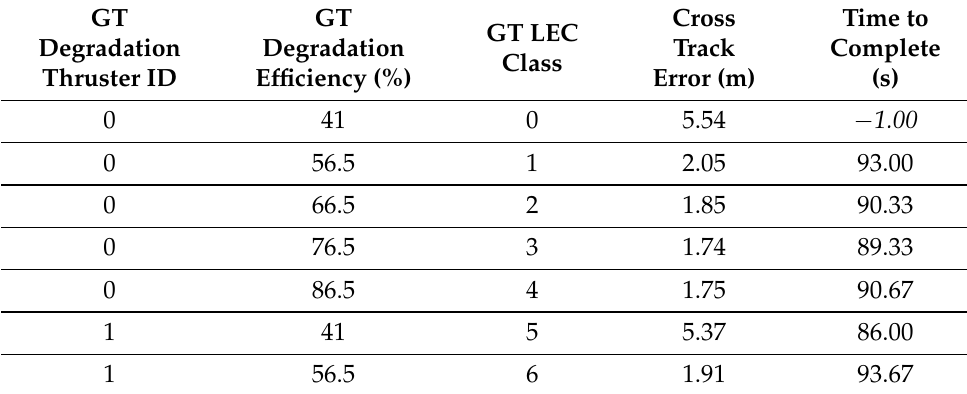
Table 4. Waypoint scenario without